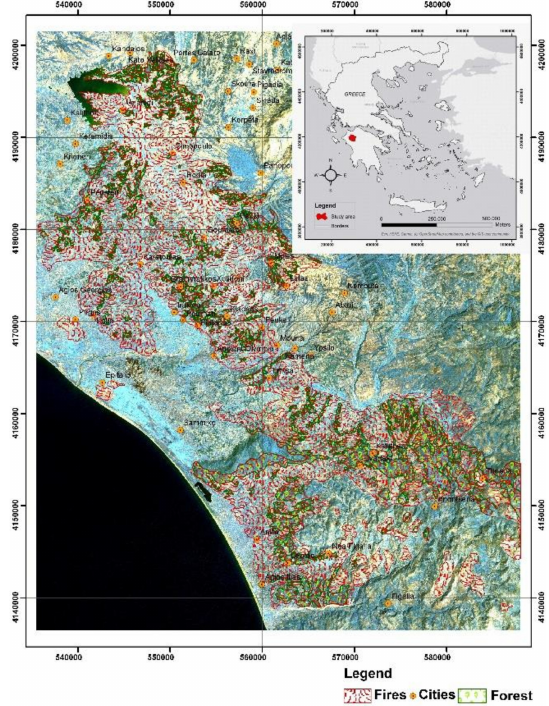
Figure 2. The burned area presented in a Landsat imagery